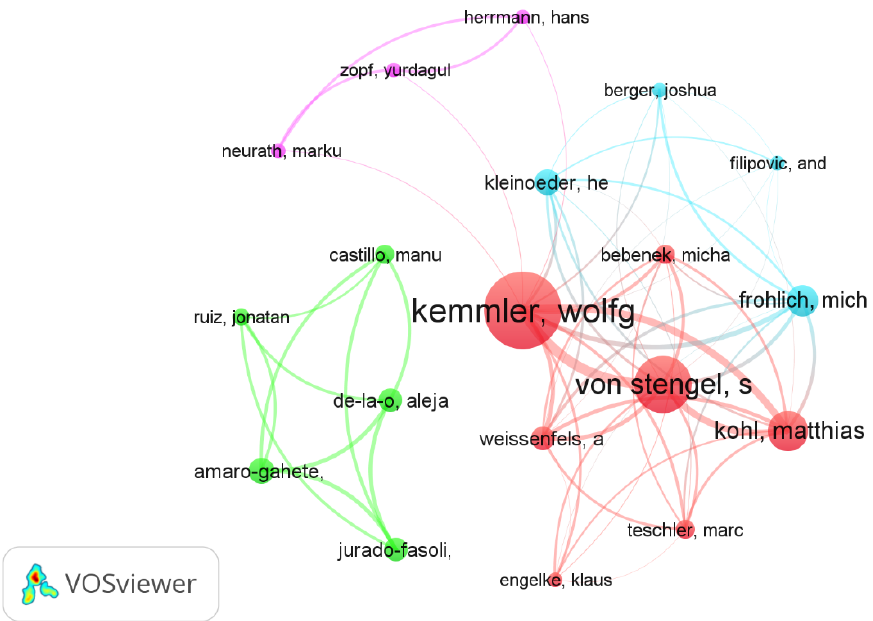
Figure 3. Co-authors graph on WB-EMS (19 prolific authors).